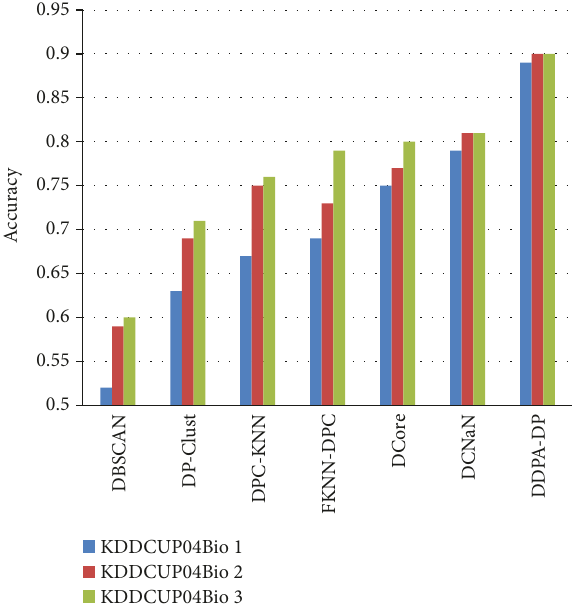
Figure 20: The simulation results in KDDCUP04Bio.